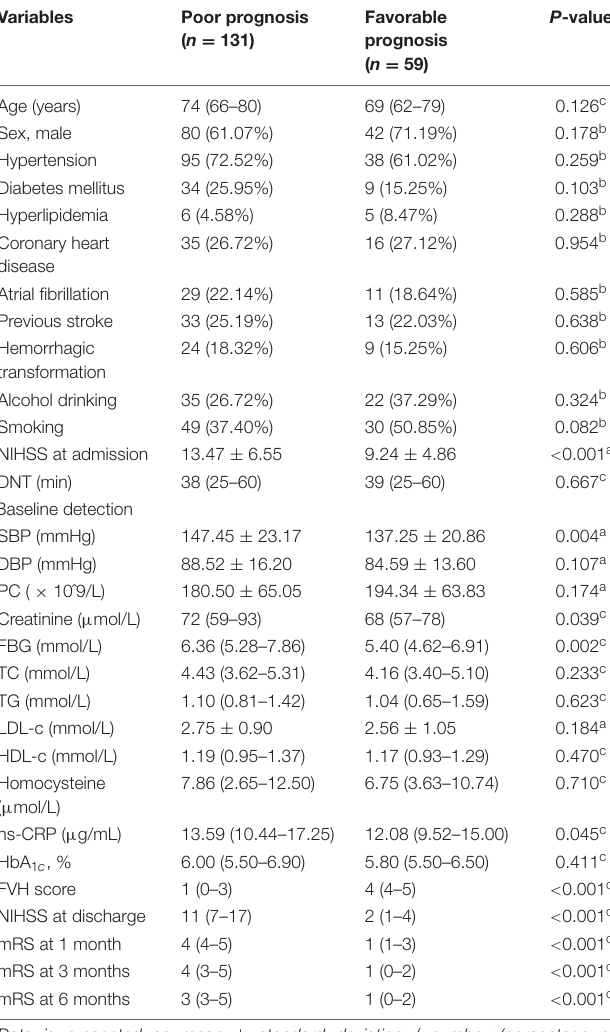
TABLE 2 | Logistics analysis for the association between baseline clinical features and prognosis in all